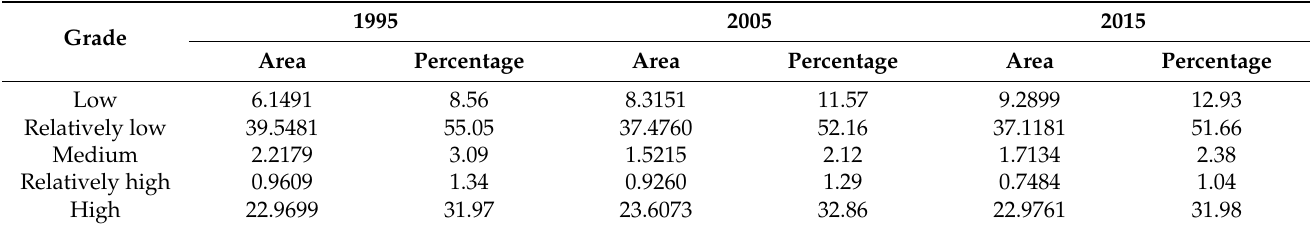
Table 5. Area and percentage of habitat quality at all grades (10 4 ha,